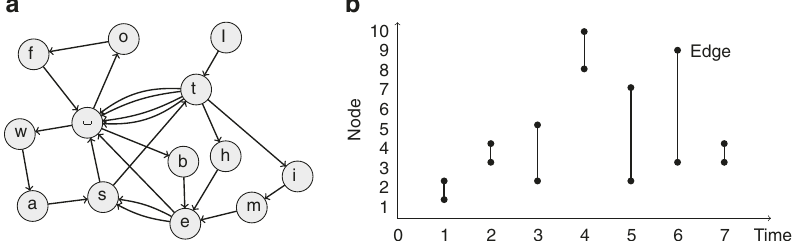
Fig. 1 Uni fi ed modelling of dynamics on and of networks. Our modelling framework simultaneously describes: a Arbitrary dynamics taking place on networks, represented as a sequence of arbitrary tokens that are associated with nodes, in this example { x t } = ‘ It-was the best of times ’ . b Dynamics of networks themselves, where the tokens are node-pair edges that appear in sequence, in this example { x t } = {(1, 2), (4, 3), (5, 2), (10, 8), (7, 2), (9, 3), (3,